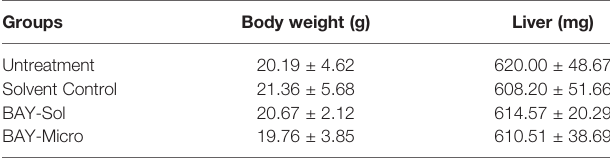
TABLE 2 | The body-weights and liver-weights of mice mentioned in Figure 5 .